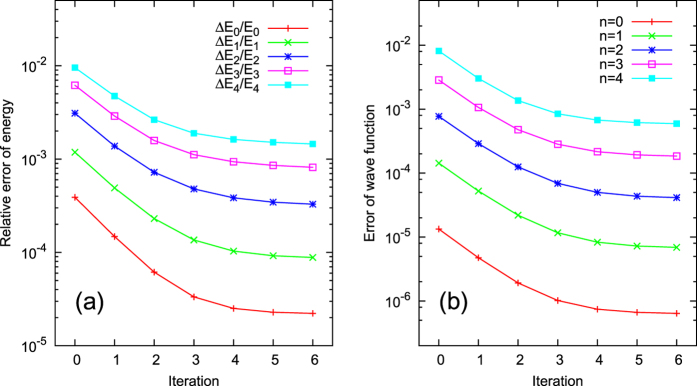
(a,b) Same as Figs 1 and 2 respectively, except that N = 31 and the harmonic potential is replaced by a Morse potential.